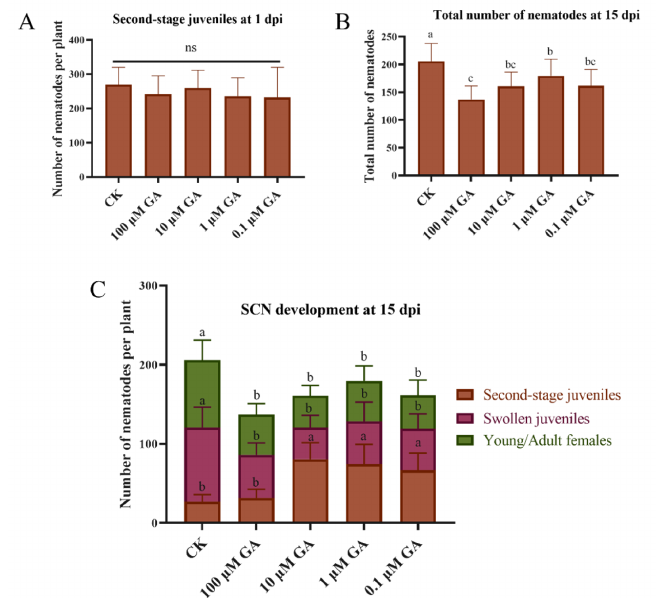
Figure 9. The effects of different concentrations GA 3 on the development of SCN. ( A ) Penetration assay at 1 dpi. ( B ) Total number of nematodes counted at 15 dpi. ( C ) Different stage nematodes counted at 15 dpi. Multiple statistical comparisons between nematodes in control roots and GA treated roots were made by one-way analysis of variance (ANOVA) followed by the LSD post hoc test. Different characters mean significant differences found at p < 0.05 level. ns, not significant. Error bars represent the standard deviation from the